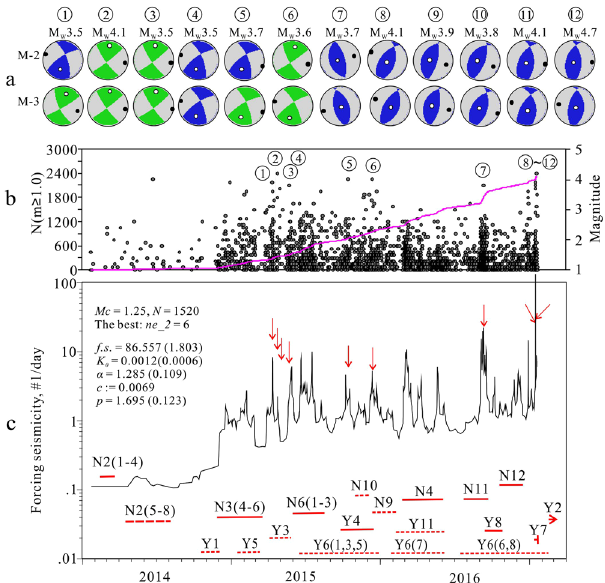
Figure 2. Epidemic-type aftershock sequence (ETAS) model results for earthquakes occurred in the Shangluo shale gas block (Fig. 1A) from 2014 to 20 Jan. 2017. ( a ) Mechanism solutions of the largest earthquakes (indicated by circled number and arrows) estimated by the gCAP method using two velocity models. ( b ) M-t and N-t plots. ( c ) ETAS parameters and their standard errors (number in brackets) (see Method section and Supplementary Fig. 5 for details). The time-varying forcing rate is plotted with respect to time. The red solid and dashed lines show major hydraulic fracturing time windows, and N# and Y# indicate the associated well pad numbers in the Ning-201 and Ys108 shale blocks,